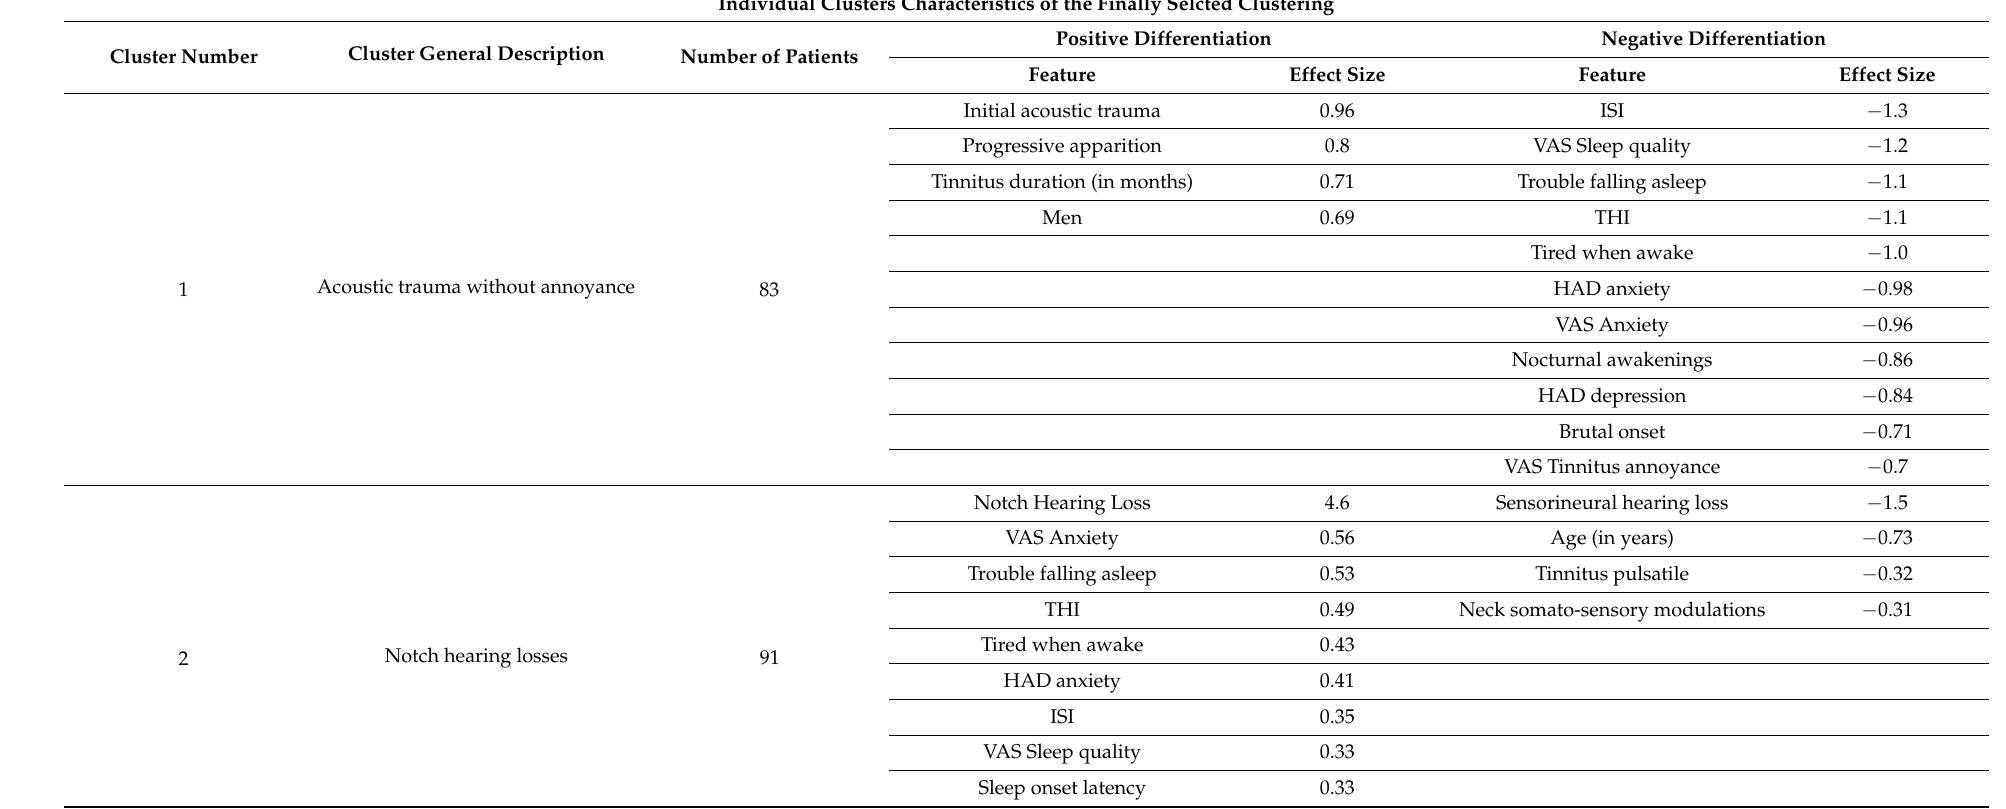
Table 7. Characteristics of the clusters of the selected clustering. The pooled Cohen’s D was used as the effect size measurement. If a feature is present in the positive differentiation column, it means that the mean score of this feature for the patients in this cluster is more elevated than the mean of this feature for the rest of the patients, with the Cohen’s D effect size given in the associated effect size column. Conversely, if a feature is present in the negative differentiation column, it means that the mean score of this feature for the patients in this cluster is less elevated than the mean of this feature for the rest of the patients. As an illustration, in Cluster 2, THI is present in the positive differentiation feature. This means that the patients in Cluster 2 have a more elevated THI score than average, whereas if the feature age is present in the negative differentiation column, it means that the patients of Cluster 2 are younger than the rest of the tinnitus patients’ sample. Individual Clusters Characteristics of the Finally Selcted